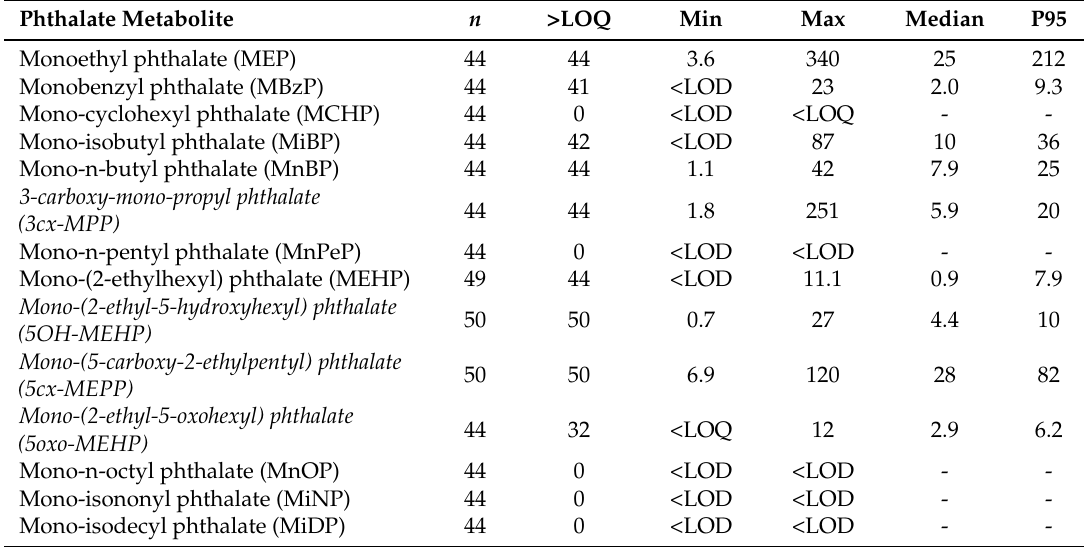
Table 2. Creatinine-adjusted concentrations of phthalate metabolites in urine samples of children (in µ g/g creatinine) ( secondary metabolites in italics ).